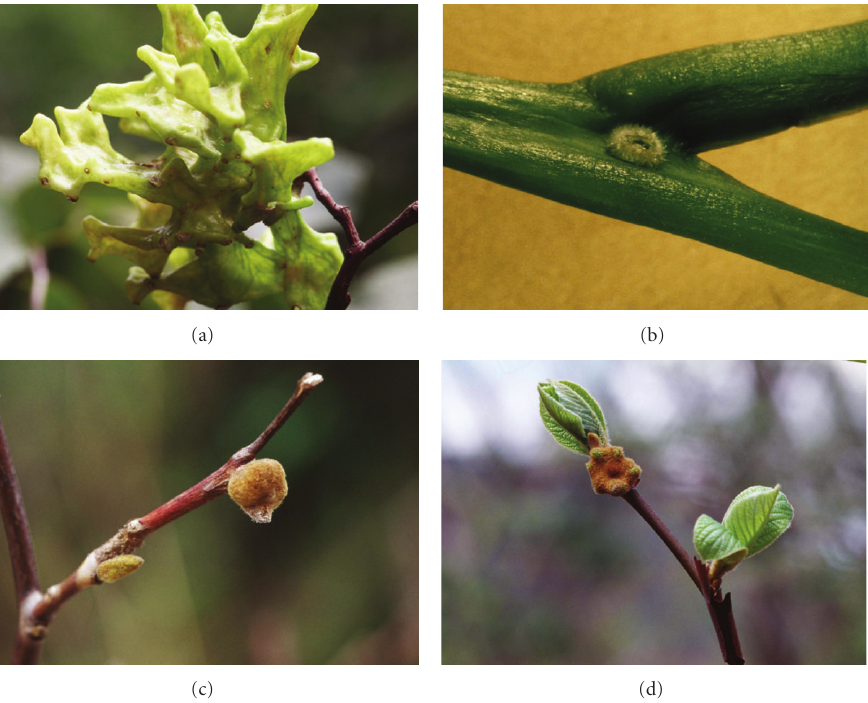
Figure 5: Galls of Tuberaphis styraci on Styrax obassia (ShomaruPass,Japan).(a)A mature gall (15 July 1996). (b) An incipient (yet unclosed) gall on the stem of a developing shoot (23 May 1986). (c) A hibernating gall and a winter bud which has not yet burst (10 April 1989). (d) A hibernated gall that has resumed growing at the time of bud burst (17 April